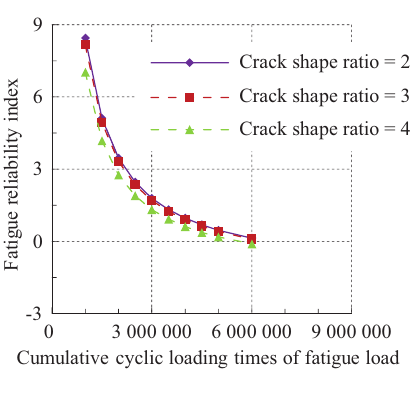
Figure 9. Fatigue reliability index under different random